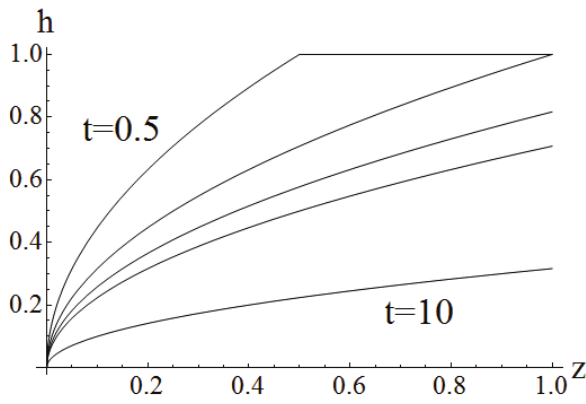
from the centrifuge for z > 1. The initial profile is not differentiable at the point z = 0, h = 1. This point propagates forward in time and persists until time ¯ t = 1 as shown in Figure 5.